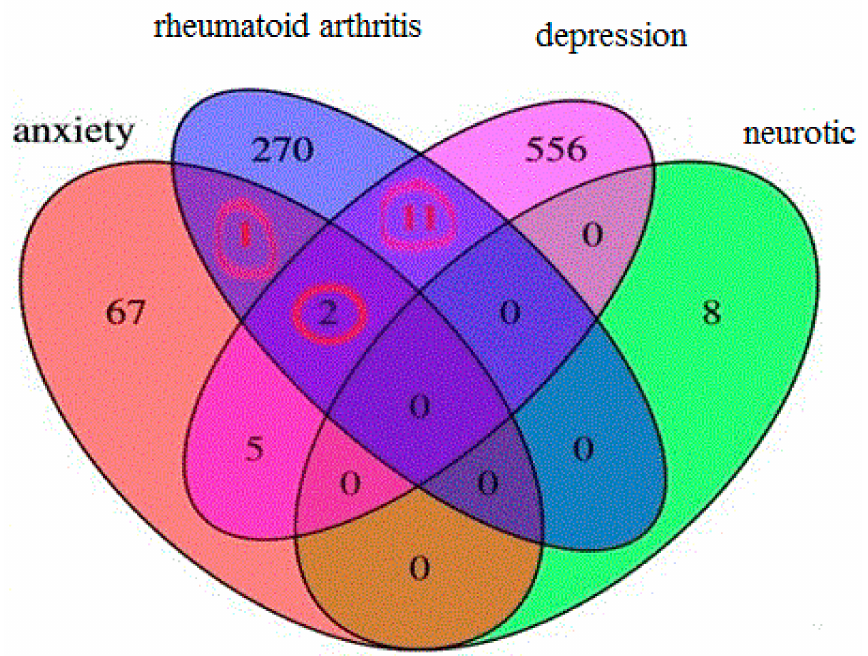
Figure 2. Search results in the GWAS Catalog: SNPs of 14 genes are associated with both RA and distress. The numbers of SNPs associated both with RA and distress are circled in